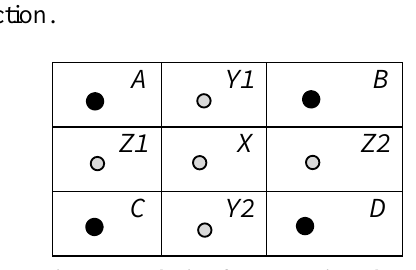
Figure 4. A design for correcting